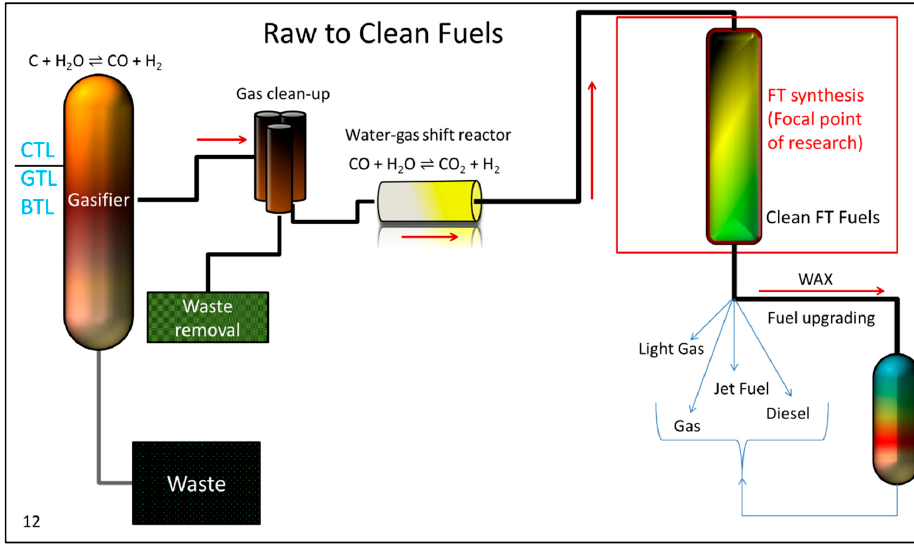
Figure 1. A simplified diagram of the Coal-to-Liquids (CTL), Gas-to-Liquids (GTL), and Biomass-to-Liquids (BTL) processes.